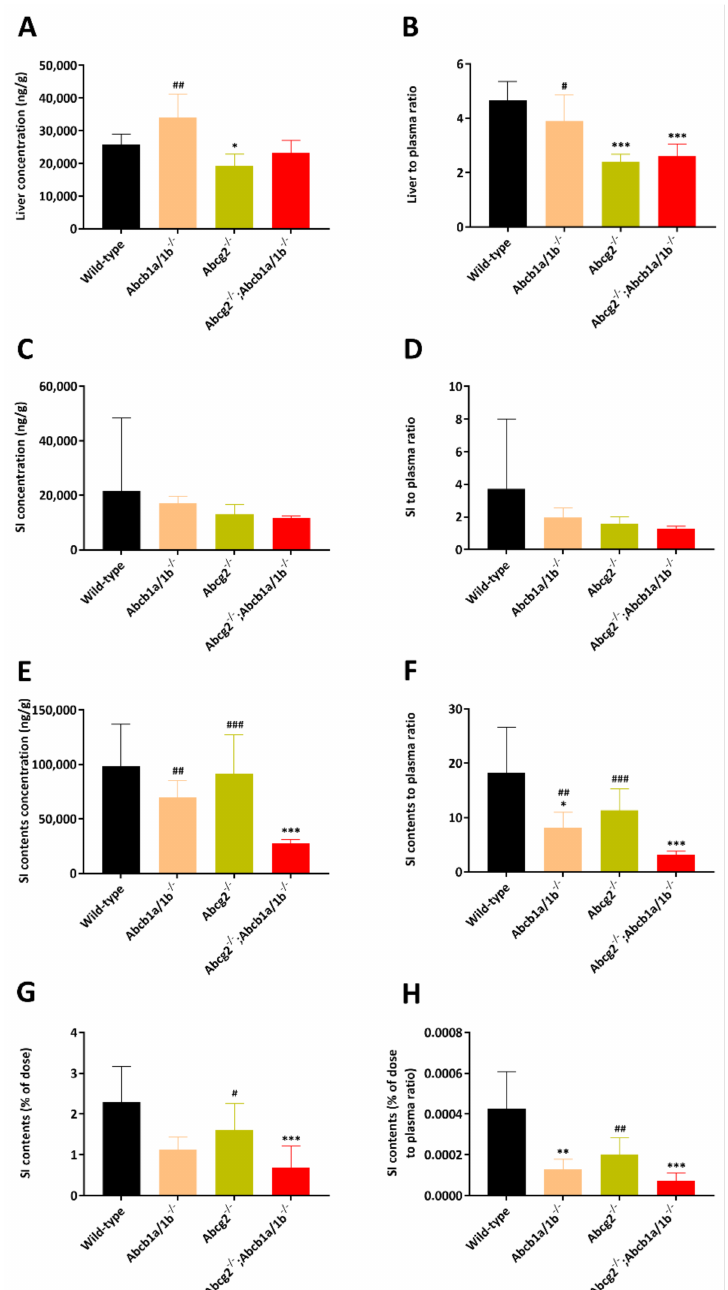
Figure 6. Liver, small intestine and small intestine contents concentrations ( A , C , E ), liver, small intestine- and small intestine contents-to-plasma ratios ( B , D , F ), small intestine contents as percentage of dose ( G ) and small intestine contents percentage of dose-to-plasma ratio ( H ) of selpercatinib in male wild-type, Abcb1a/1b -/- , Abcg2 -/- and Abcb1a/1b; Abcg2 -/- mice 4 h after oral administration of 10 mg/kg selpercatinib. SI: small intestine. Data are given as mean ± S.D. (n = 6). *, p < 0.05; **, p < 0.01; ***, p < 0.001 compared to wild-type mice; #, p < 0.05; ##, p < 0.01; ###, p < 0.001 compared between Abcb1a/1b;Abcg2 -/- and Slco1a/1b -/- mice. Statistical analysis was applied after log-transformation of linear